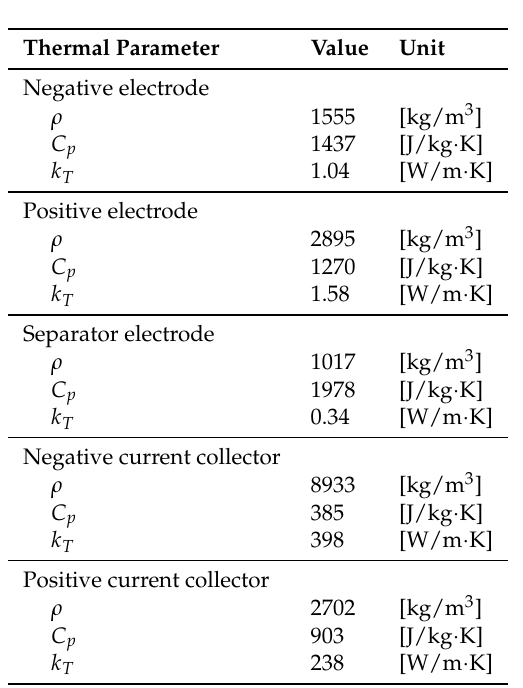
Table A4. Thermo-physical properties of the electrodes, separators, current collectors of the NMC/ Graphite type of battery